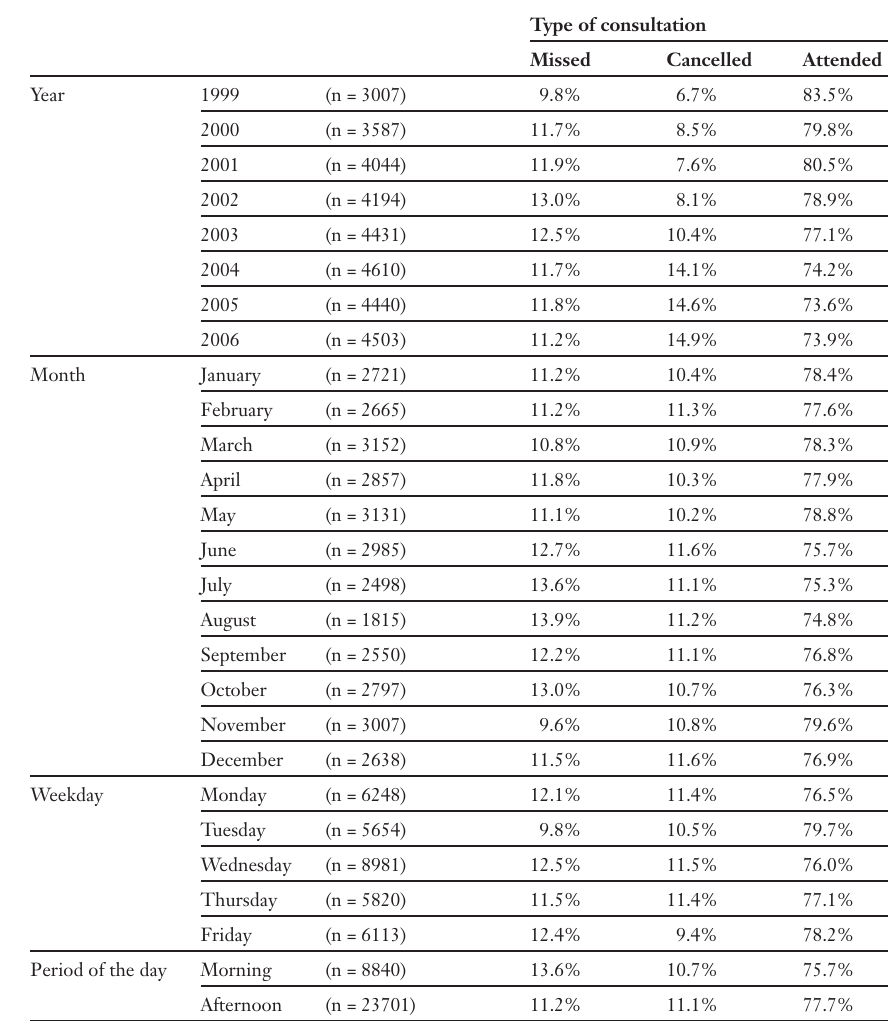
Rates of each type of appointment by year, month, week- day and period of the